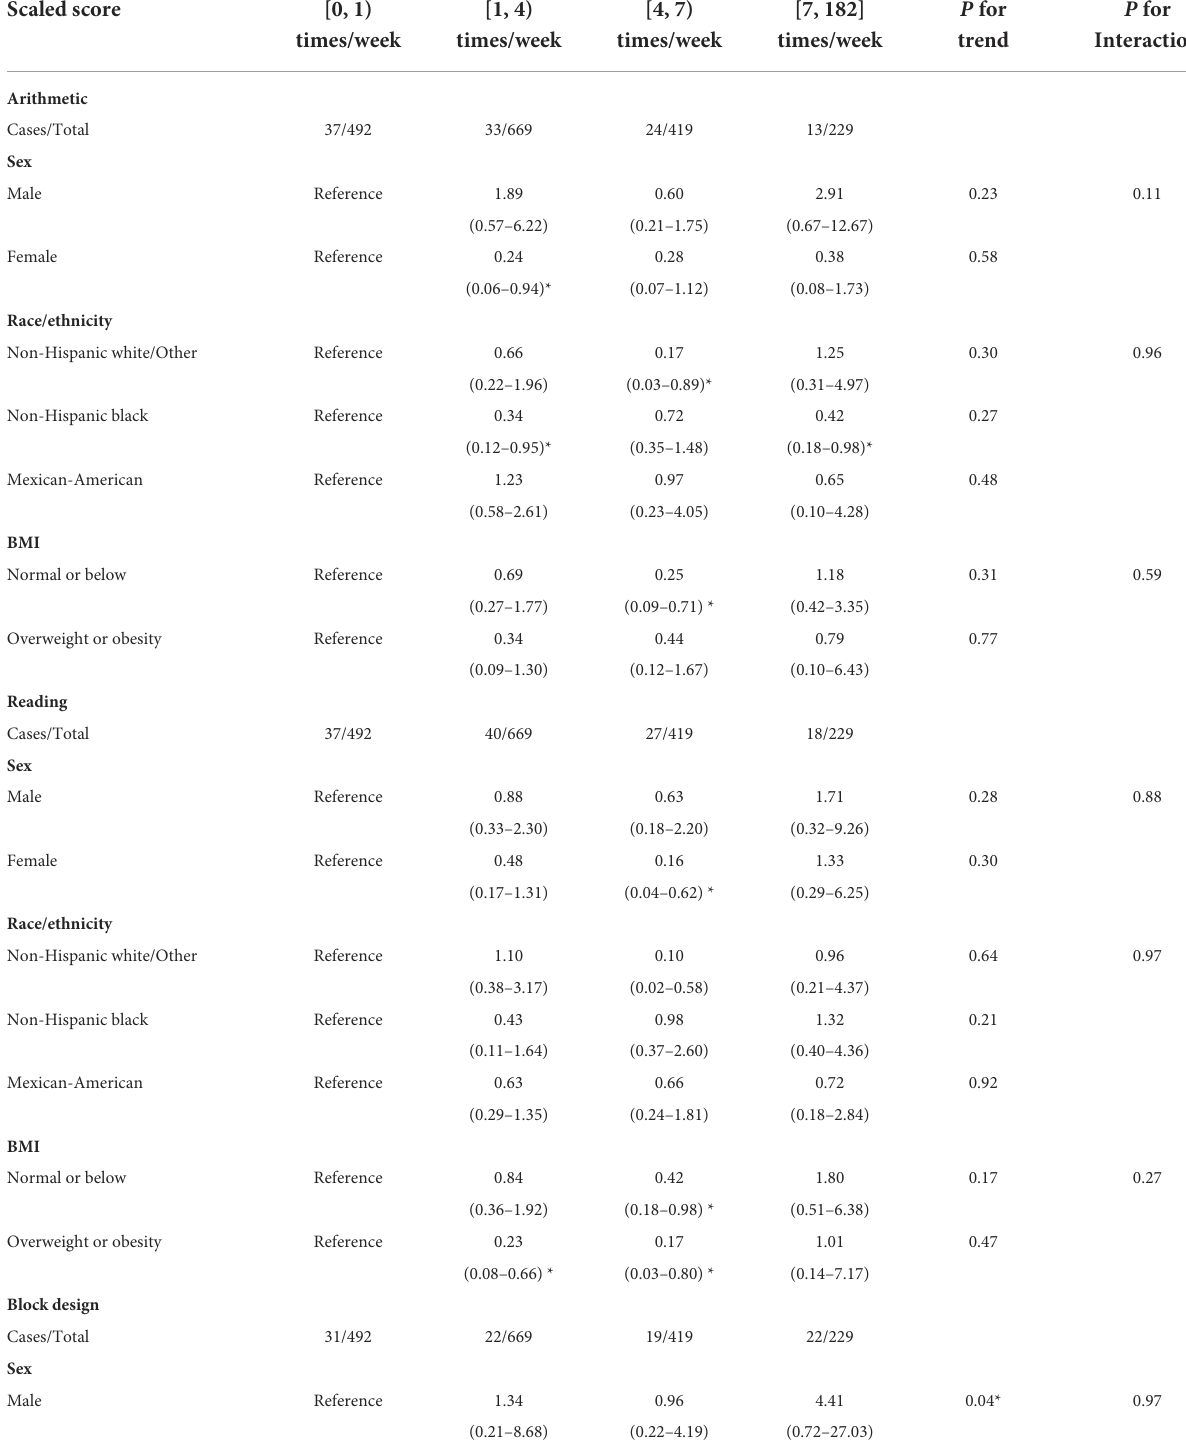
TABLE 3 Stratified analysis of the association of intake of SSBs with cognitive tests in adolescents aged 12–16 years in the United States: NHANES III,